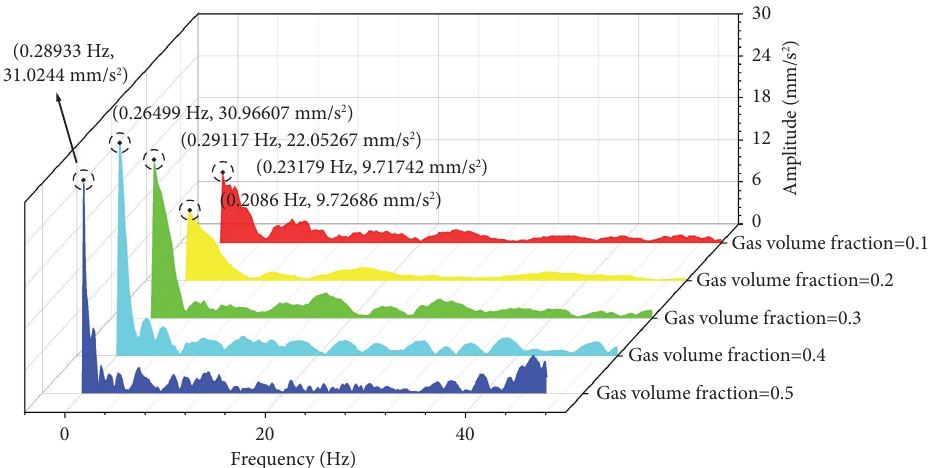
Figure 17: Te frequency-domain diagram of the vibration response of monitoring point B at diferent gas volume